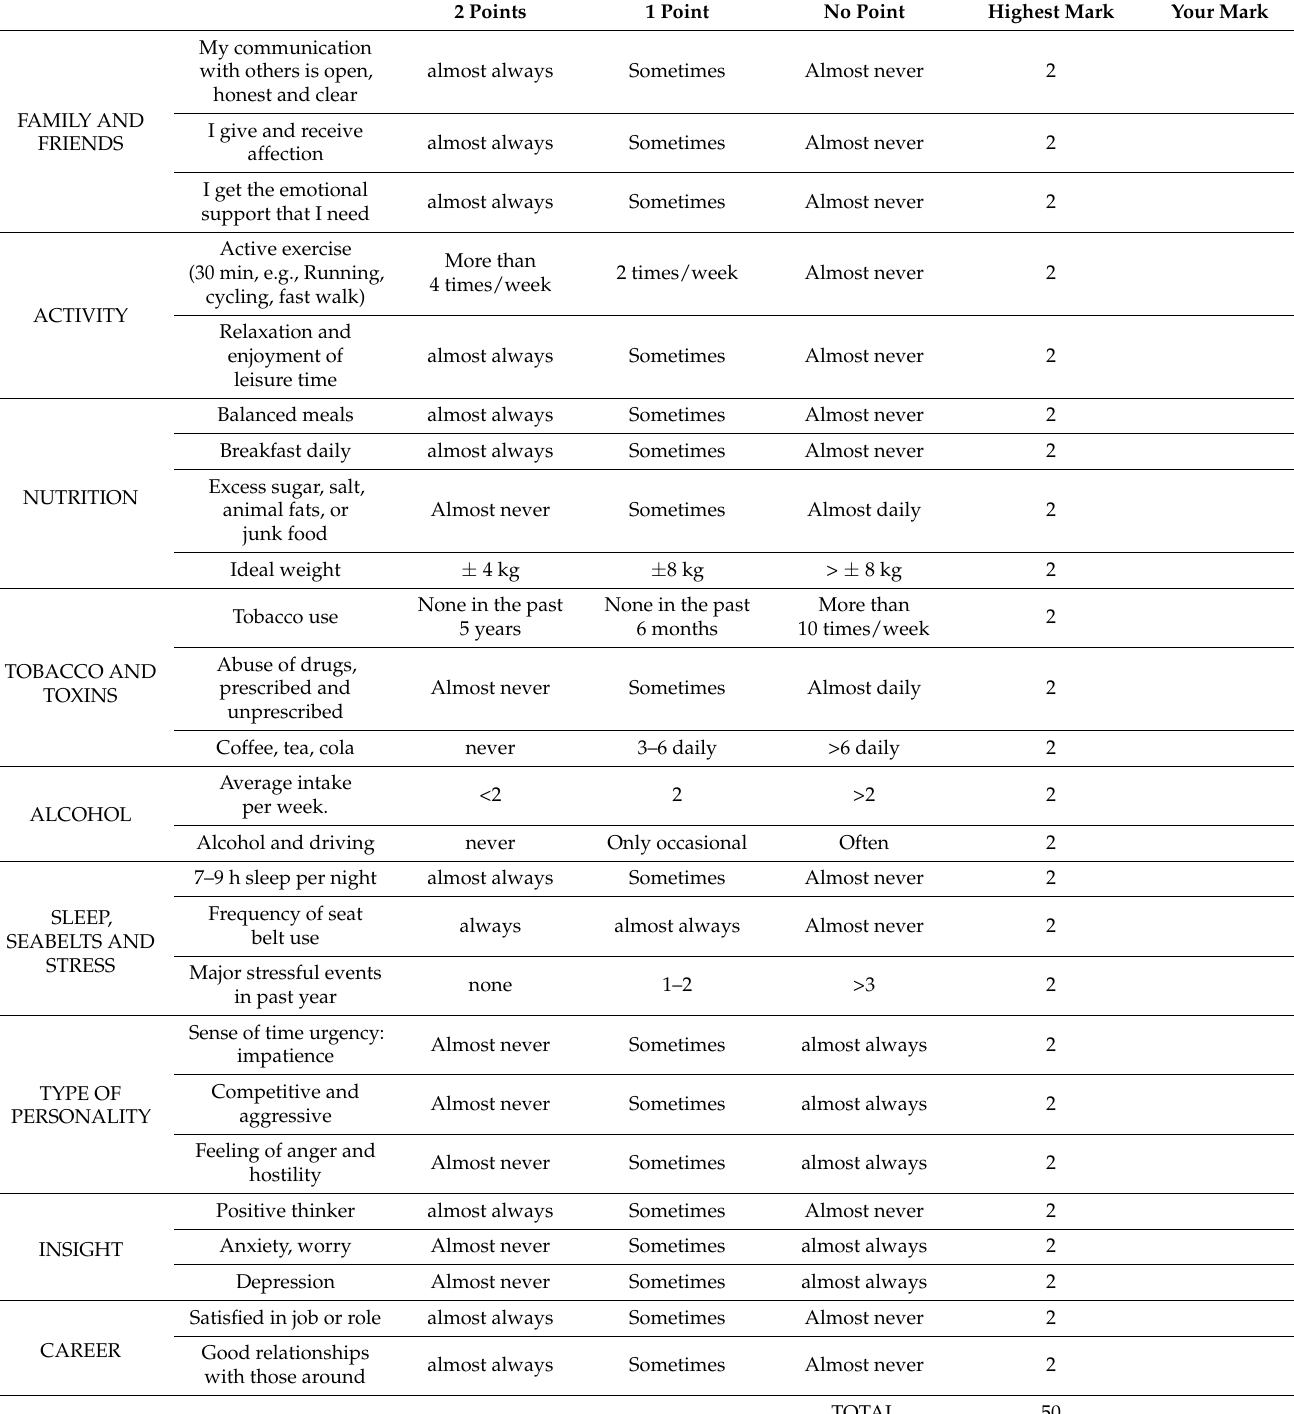
Table 1. FANTASTIC